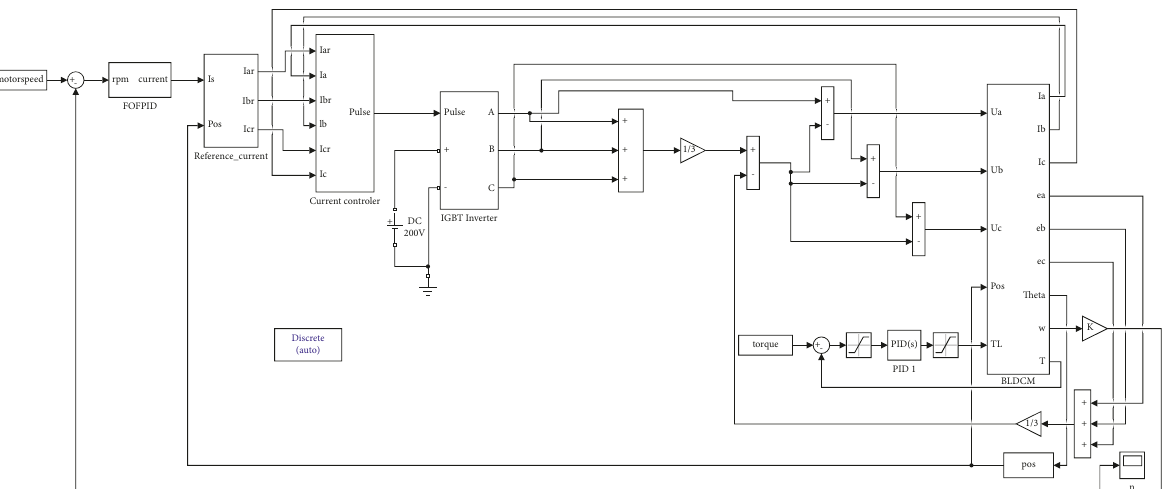
Figure 2: Simulation model of the BLDCM system in Simulink.